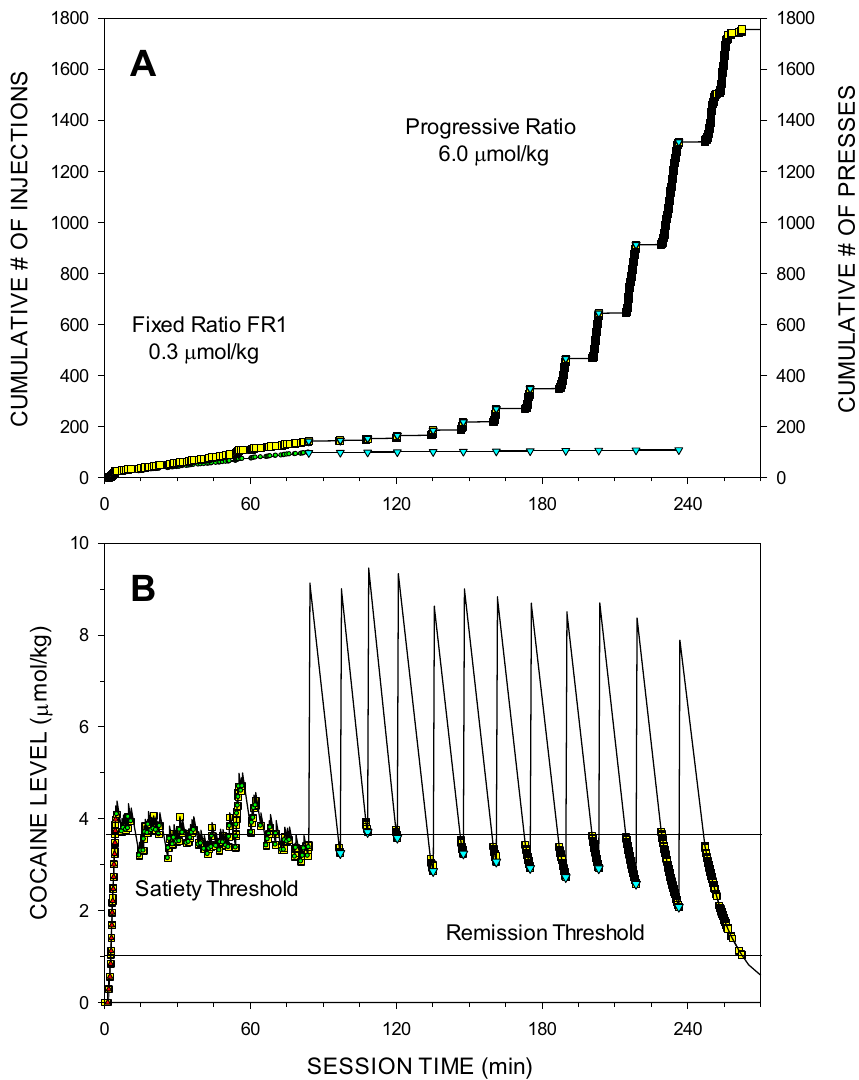
Figure 3. Cumulative records of events ( A ) and the calculated levels of cocaine ( B ) at the time of each event during a representative self-administration session under FR1 and PR schedules of delivery of low and high unit doses of cocaine (0.3 (green circle) and 6.0 (cyan inverted triangle) µmol/kg, respectively). For detailed figure legend see Fig. 2. ( A ) The mean ± SEM inter-injection intervals during loading and maintenance phases under the FR1 schedule were 13.1 ± 1.8 s (red triangle) and 58.9 ± 5.2 s (green circle), respectively. Between PIPs under the PR schedule, the mean ± SEM local inter-press interval was 2.53 ± 0.69 s ( LR = 41.4 ± 6.0 presses/min). The last completed ratio was 403. The number of presses of final extinction presses was 443, therefore BP = 443 presses. ( B ) Horizontal lines represent mean ± SEM D ST = 3.64 ± 0.039 µmol/kg and the D RT = 1.03